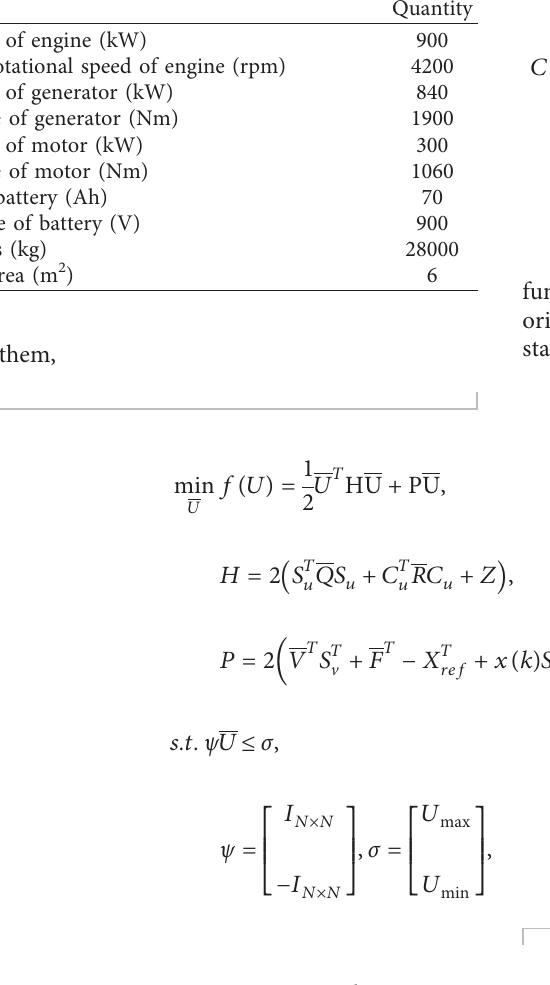
Table 2: Basic parameters of main power components. Parameters